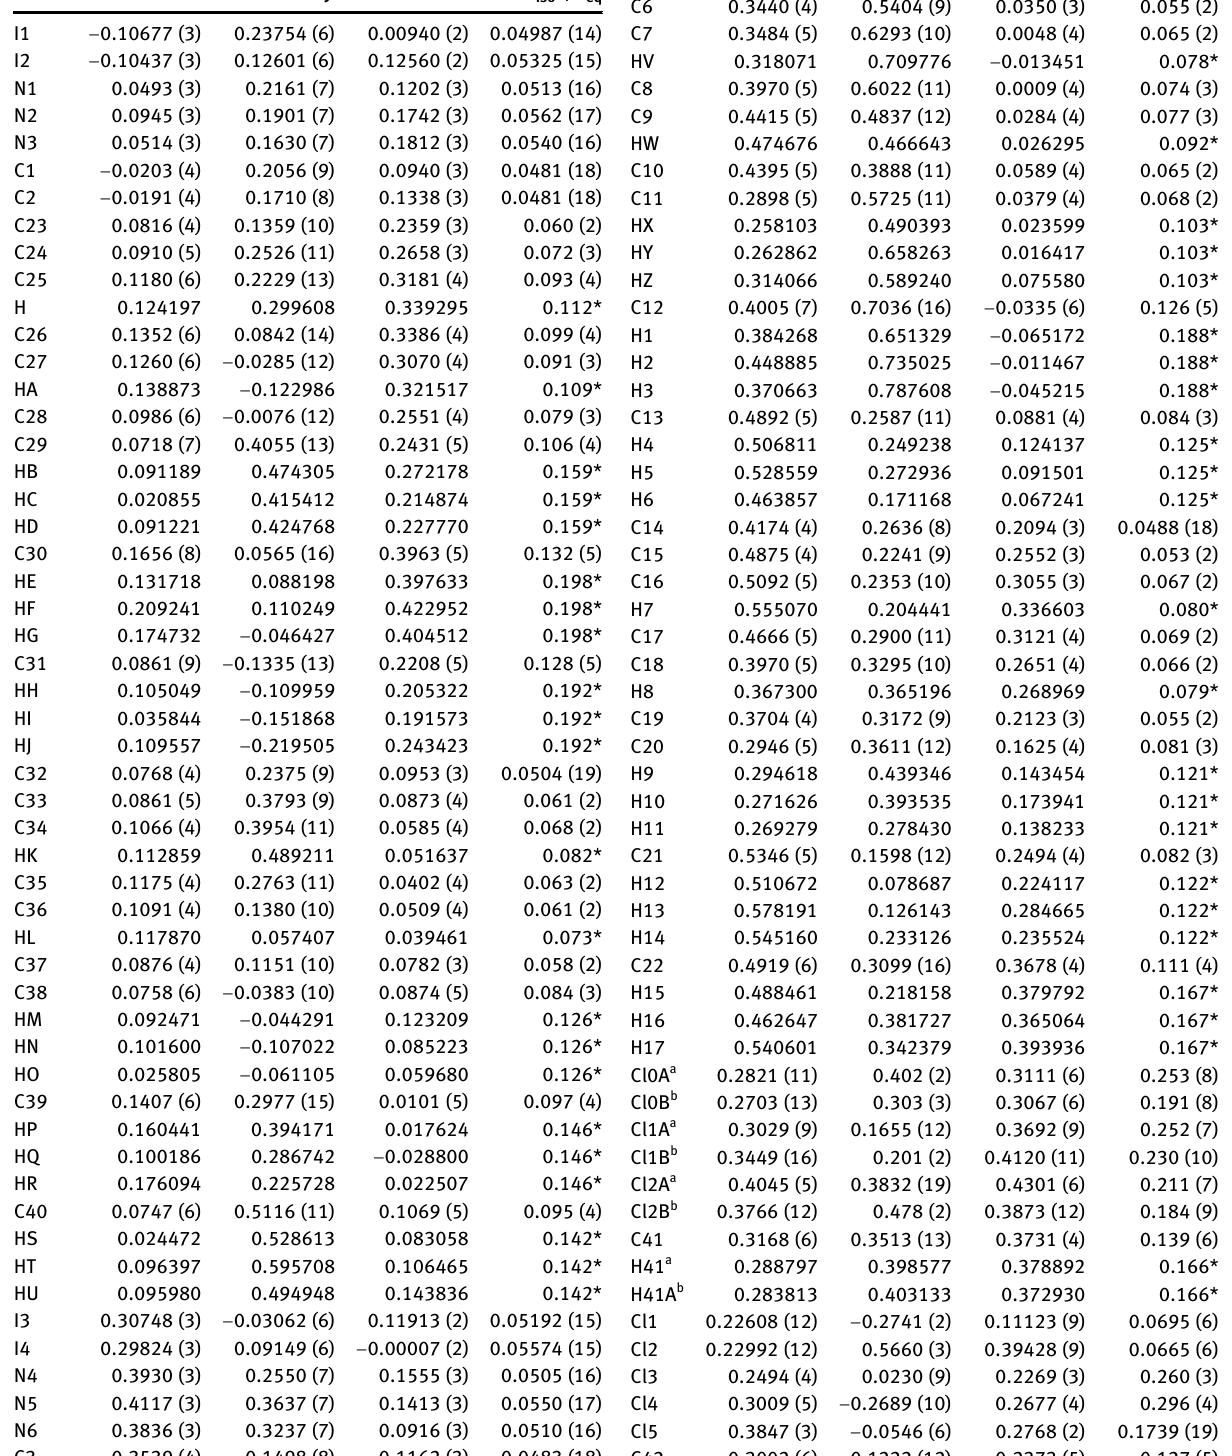
Table  : Fractional atomic coordinates and isotropic or equivalent isotropic displacement parameters (Å 